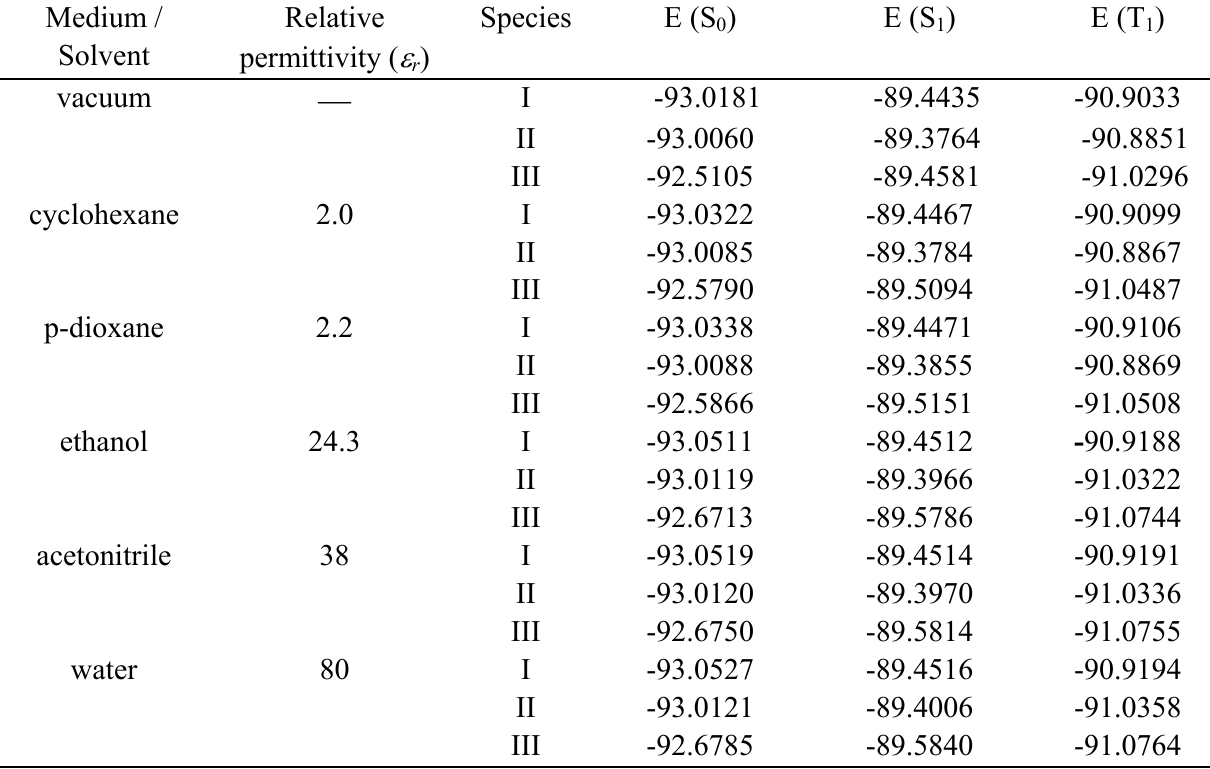
, S and T energies (eV) of the normal (I), rotamer (II) and tautomer (III) of Table 6. Calculated S 0 1 1 HPO in isolated and solvated conditions (Onsager’s cavity radius, a = 4.25 Å). Medium /